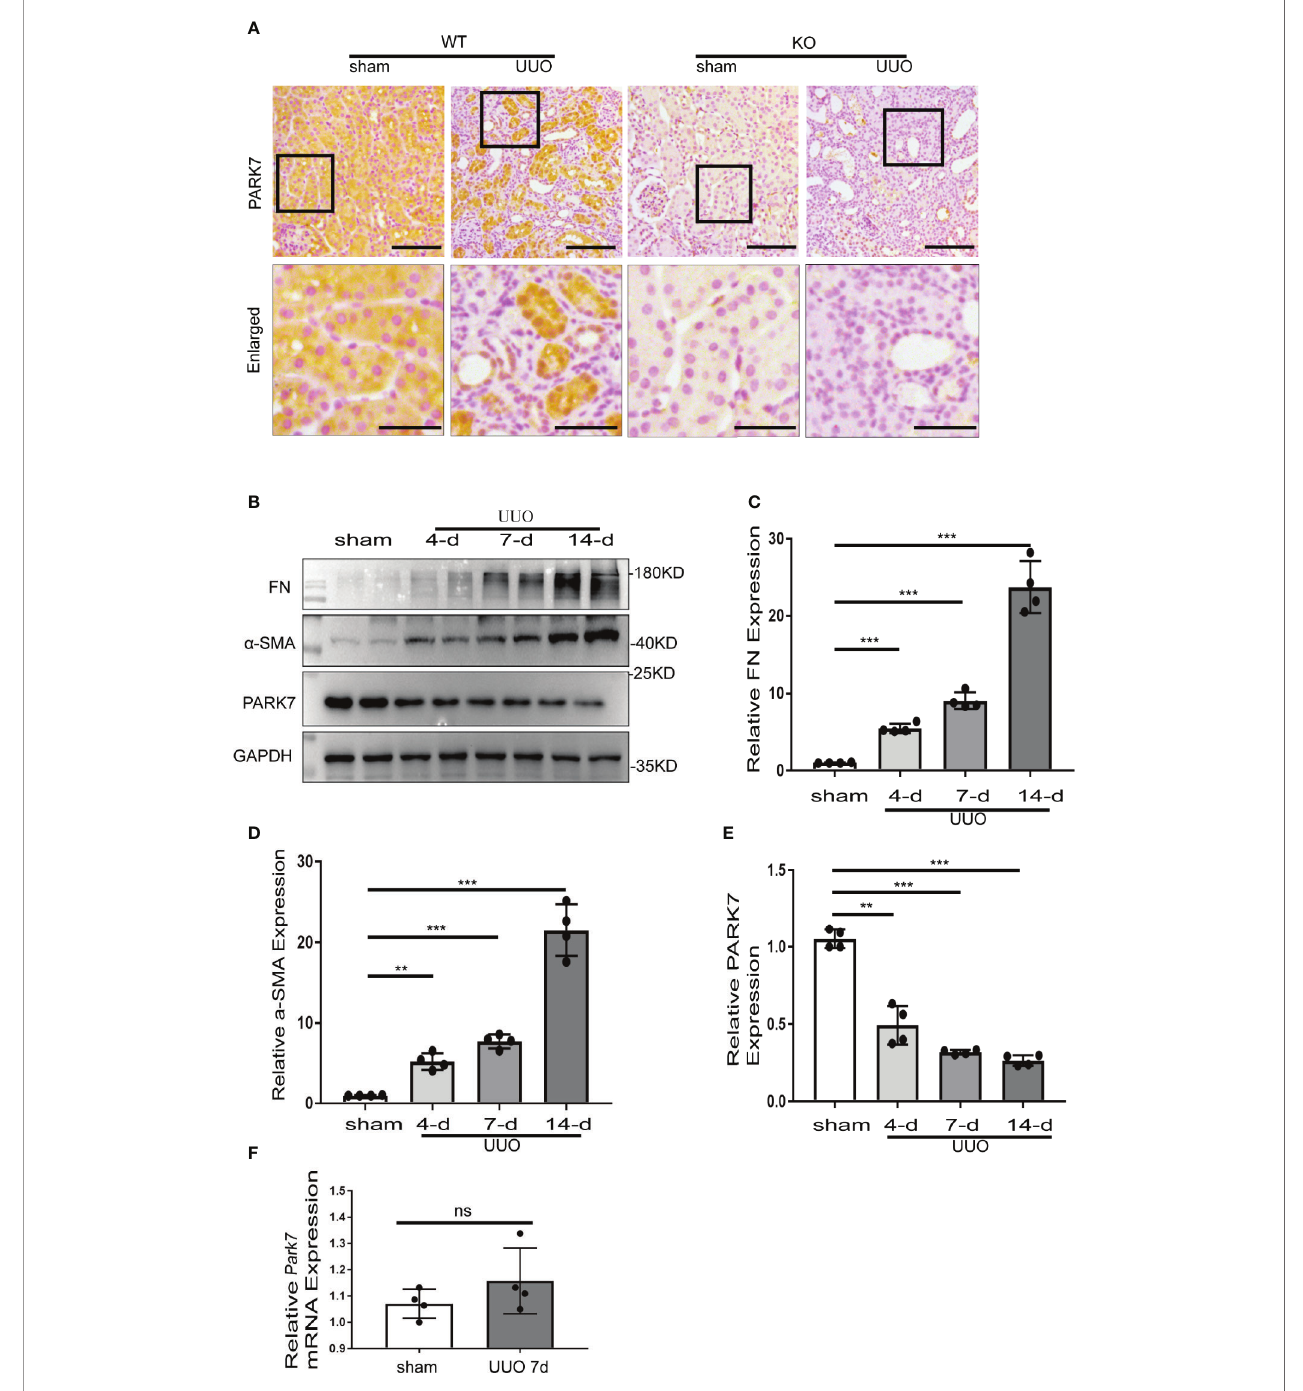
FIGURE 1 | PARK7 is reduced in renal proximal tubules during UUO. C57BL/6 mice (female, 8weeks old) were subjected to sham operation or UUO surgery. The mice were euthanized at 4 days, 7 days or 14 days after surgery, and the UUO-obstructed kidneys were collected. (A) Representative images of histochemical staining of PARK7 in kidney tissues. Bar: 100 m m in the top images and 50 m m in the bottom enlarged images. (B) Representative blots of Fibronectin (FN), a -SMA, PARK7 and GAPDH(as protein loading control). (C – E) Densitometry of FN, a -SMA, and PARK7 signals(n=4). The signal of FN, a -SMA, or PARK7 was normalized to the GAPDH signal of the same samples to determine the ratios. The values are expressed as fold change over sham control. Each symbol (circle) represents an individual mouse. (F) Quanti fi cation of Park7 mRNA levels. Error bars: SEM. **p < 0.01, ***p < 0.001. ns, not signi fi